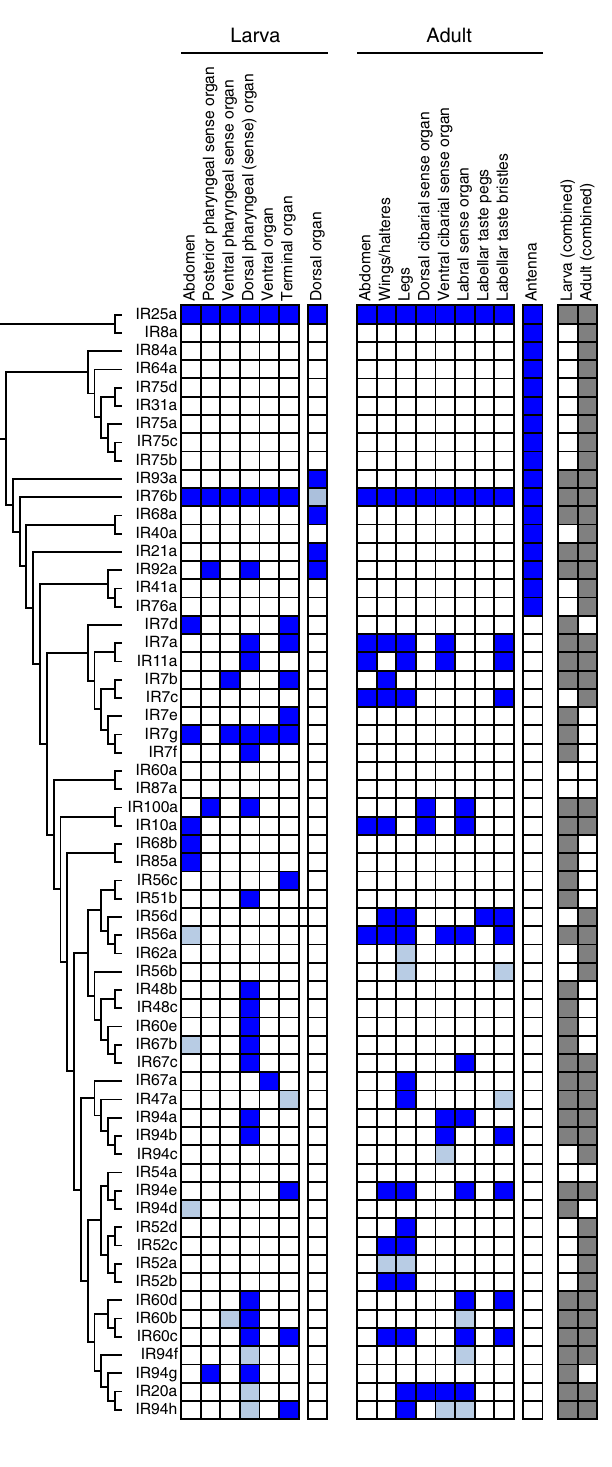
Fig. 1 Ir-Gal4 expression patterns and IR phylogeny. Summary of the expression (indicated by dark blue shading) of Gal4 drivers for the entire D. melanogaster IR repertoire in peripheral chemosensory organs in third instar larvae and adult fl ies (see also Figs 2 and 3). Some lines, in particular antennal-expressed drivers, were previously described 15,20 – 22,25,28,39, 41,74,75 . Light blue shading indicates additional expression reported for independently-generated Ir-Gal4 drivers 26,27 . We did not distinguish expression in the dorsal pharyngeal organ and dorsal pharyngeal